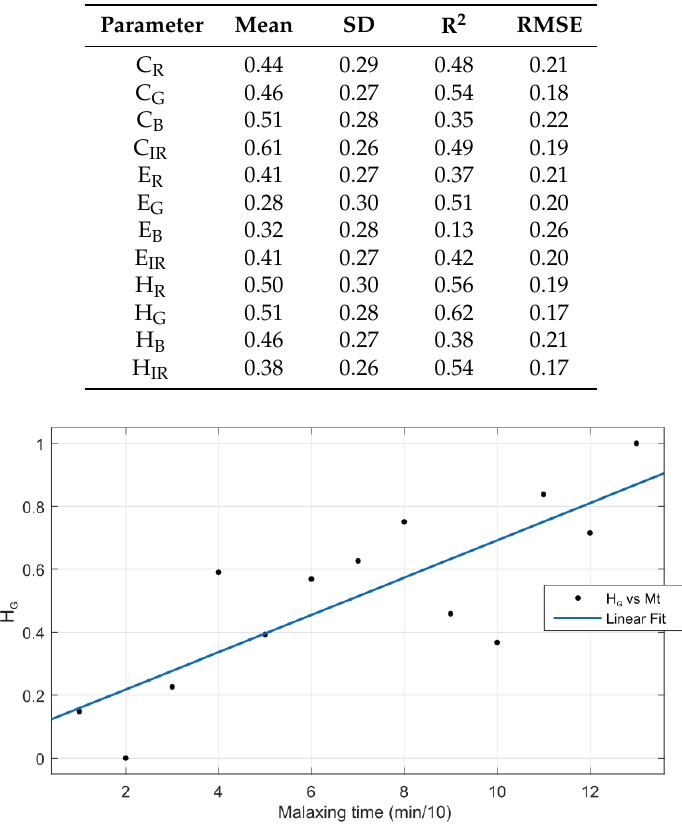
Figure 12. Homogeneity parameter in the green channel versus malaxing time.